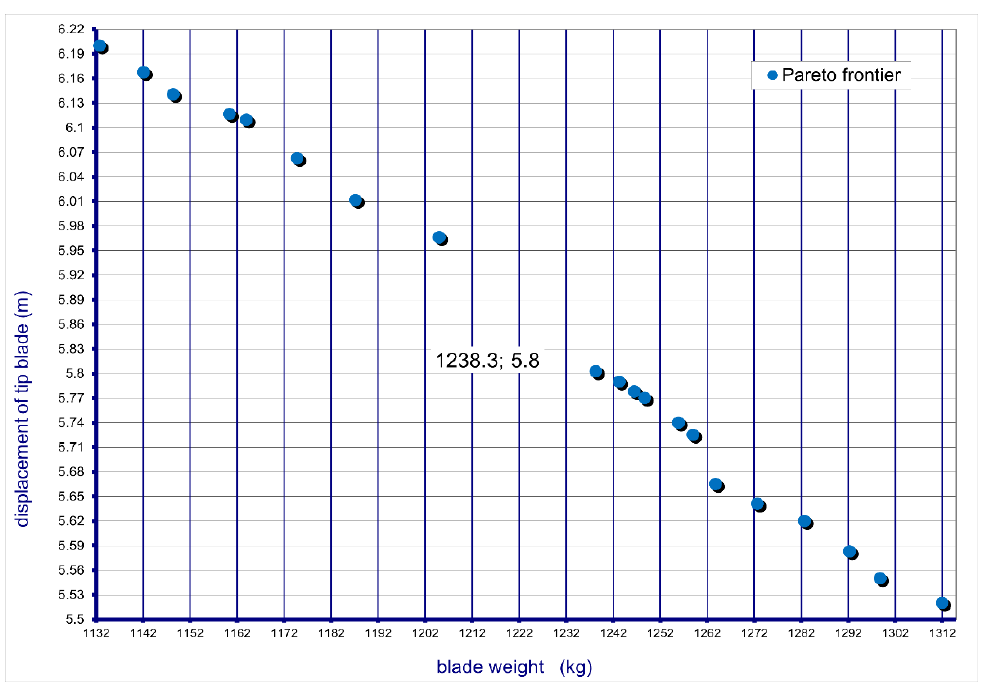
Figure 4. Pareto frontier for a multi-objective optimization problem with two objective functions. As a result of optimization, only non-dominated solutions were obtained. Therefore, all solutions for w = 0.0, 0.5, . . . , 1 form a Pareto frontier. The obtained values of the criterion function, described by the Equation (1), depending on the adopted weighting factors, are shown in Figure